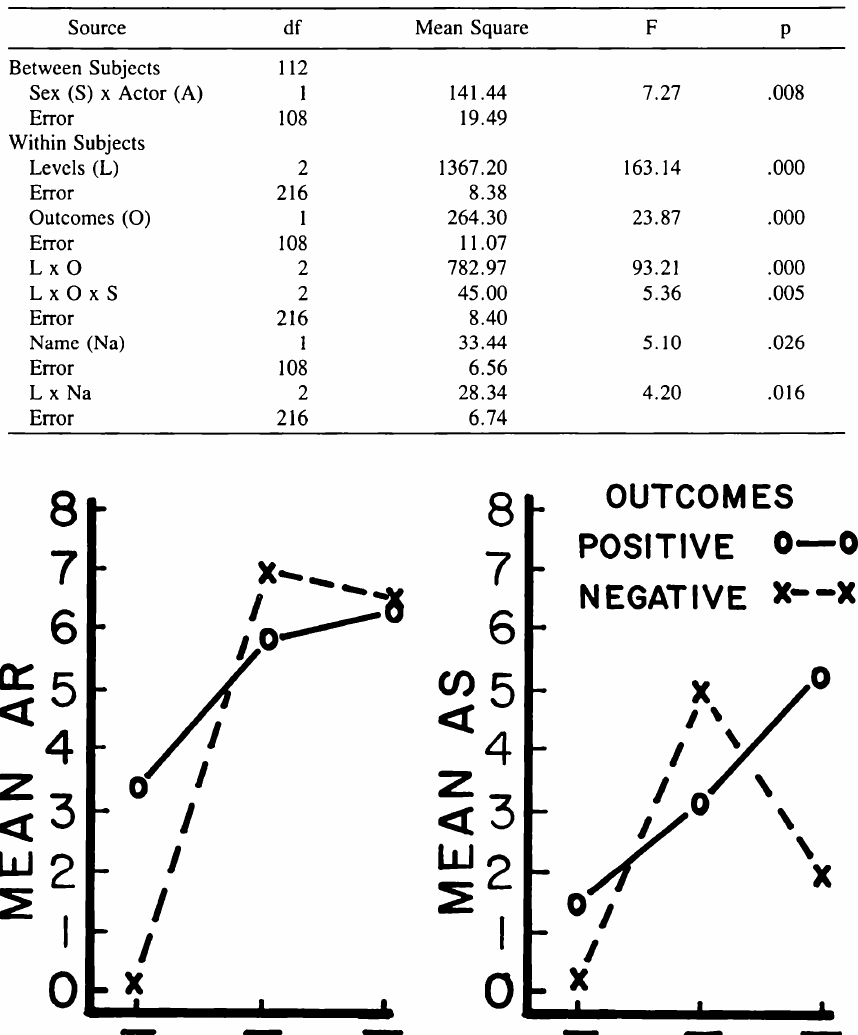
Statistically Significant Results for the Analysis of Variance of the Assignment of Sanction Ratings